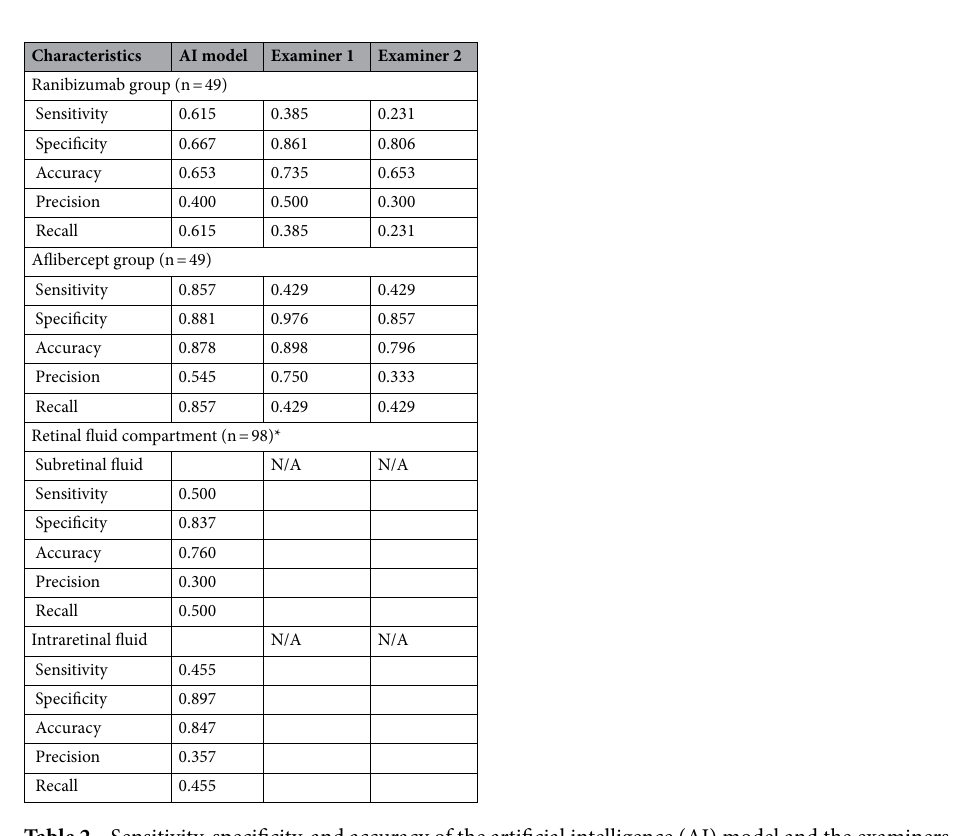
Table 2. Sensitivity, specificity, and accuracy of the artificial intelligence (AI) model and the examiners in predicting the presence of residual retinal fluid after treatment. Data are presented as percentage (%). *Evaluation of the retinal fluid compartment was performed only for the AI model. N/A, not applicable.